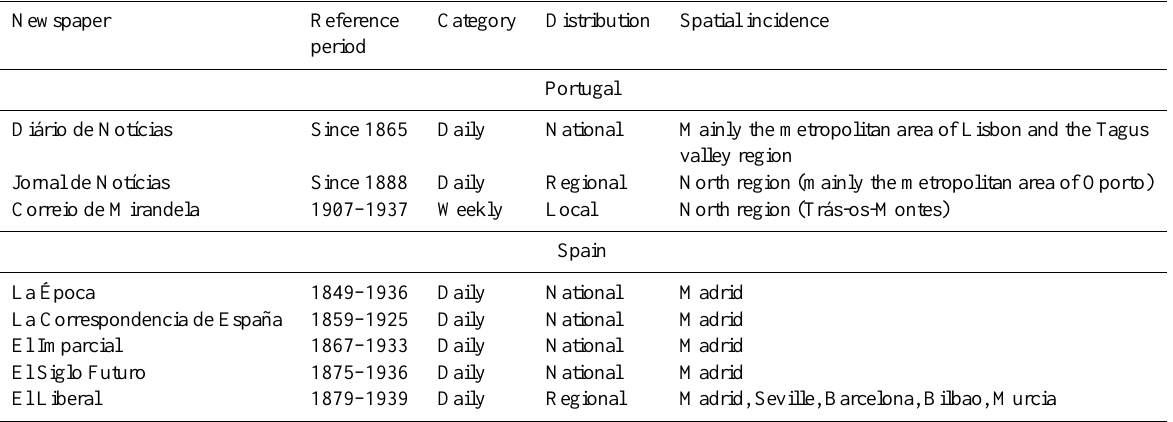
Table 1. Newspapers explored for the December 1909 event data